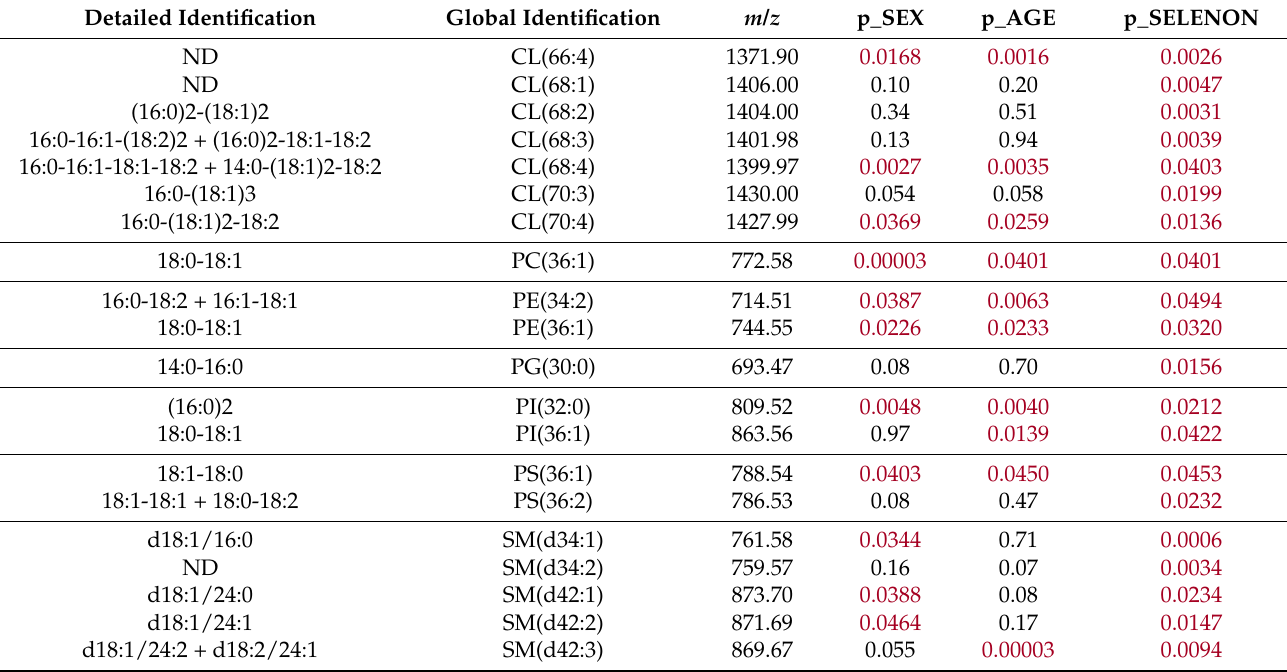
Table 4. SelenoN (genotype) significant PL in